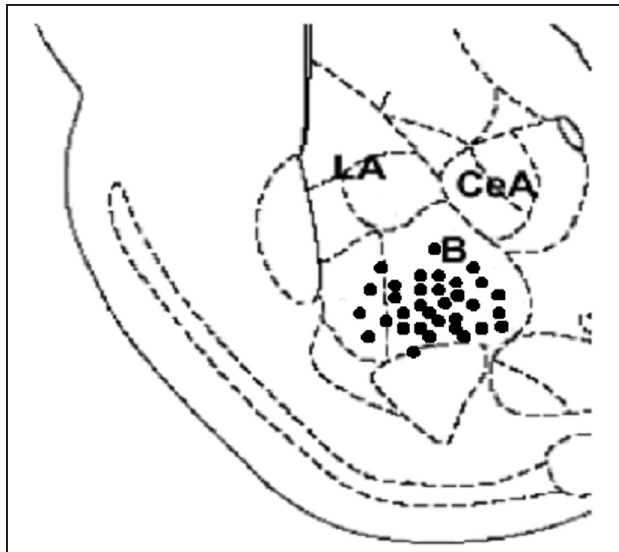
FIGURE 1 | A diagram depicting a coronal section of the rat brain (2.8–3.0mm posterior to Bregma) showing electrode placements in the BLA. Filled circles indicate locations for all BLA groups ( n = 33; B, basal amygdala; La, lateral amygdala; CeA, central